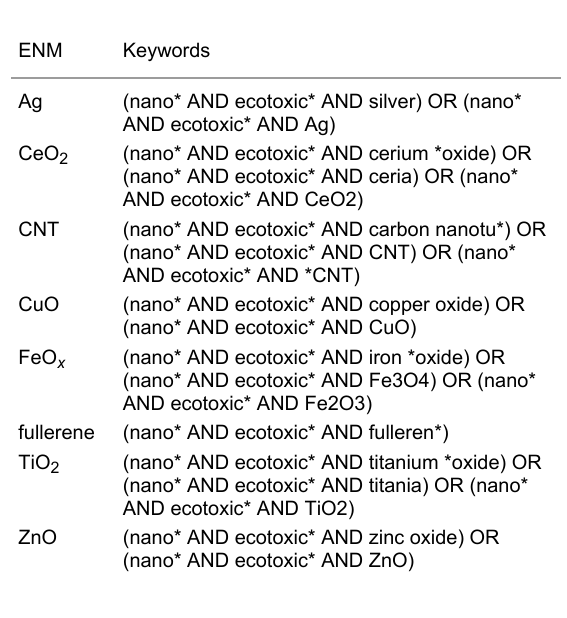
Table 1: Keywords used for bibliometric data search in Thomson Reuters WoS database.